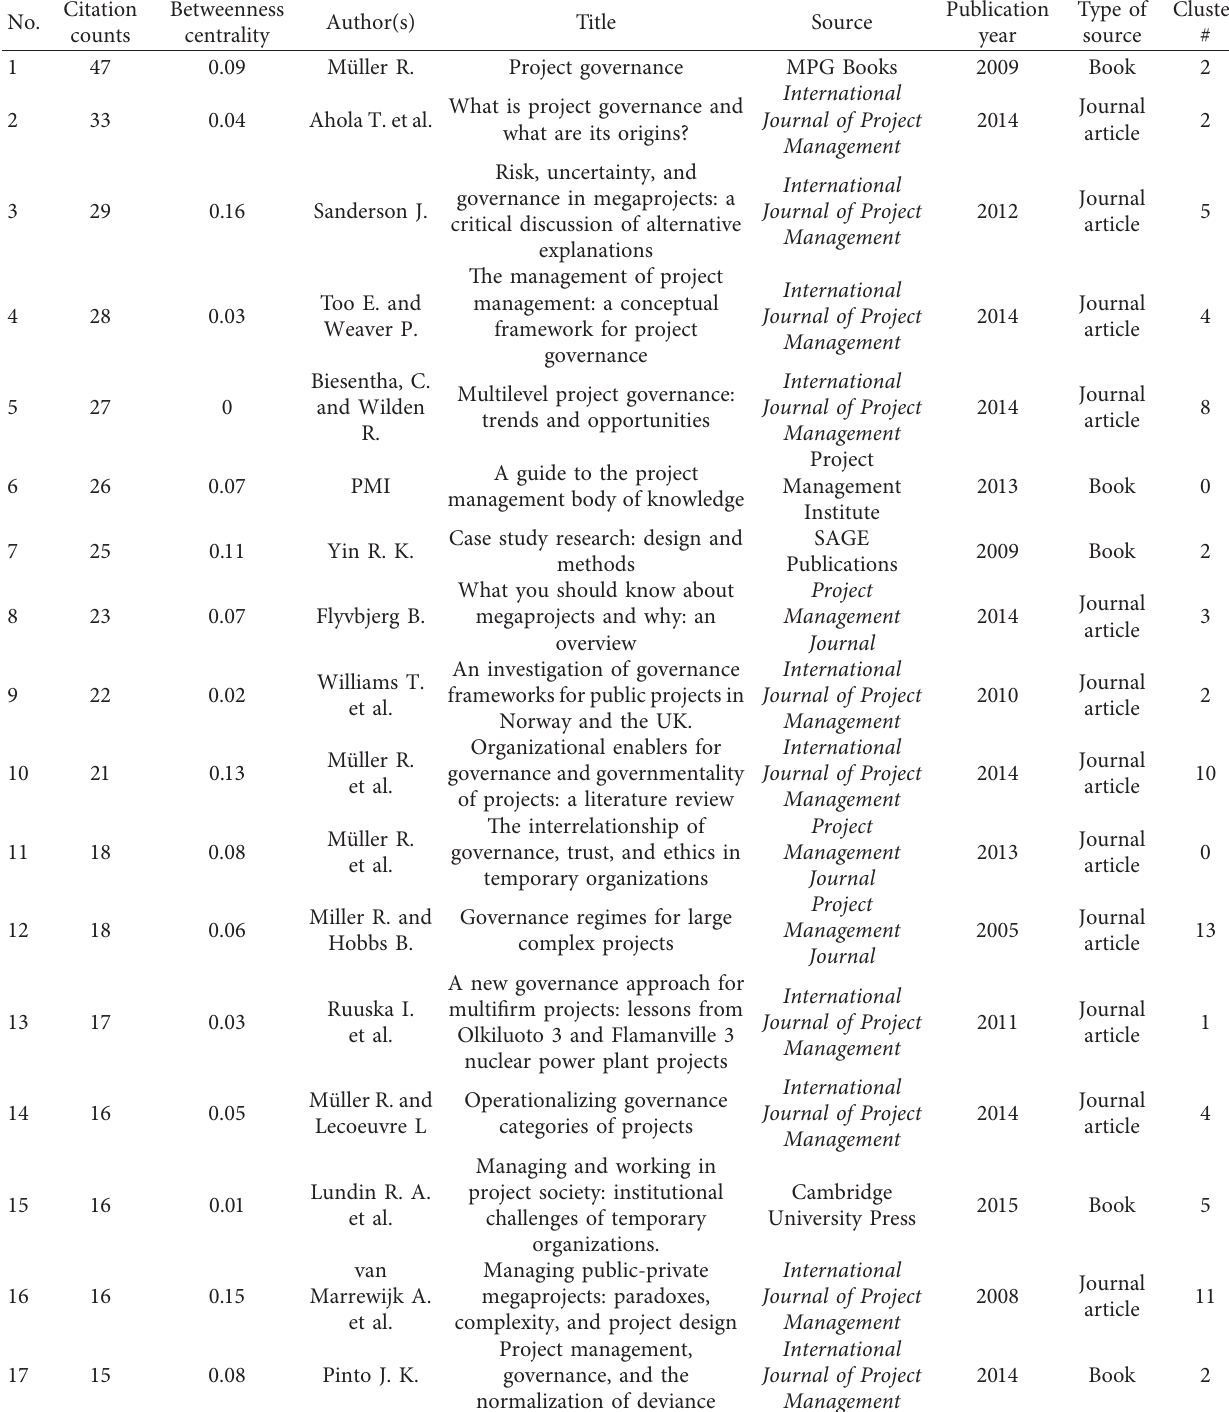
Table 3: Top 17 cited